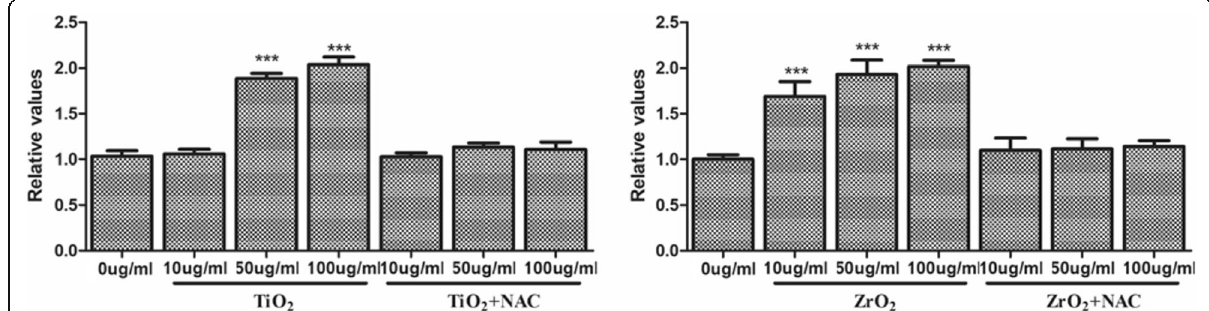
Fig. 3 TiO 2 and ZrO 2 NP-induced ROS generation in 3T3-E1 cells. 3T3-E1 cells were treated with TiO 2 and ZrO 2 NPs at various concentrations for 48 h, and NAC (10 mM) was incubated simultaneously, and then the ROS levels in the 3T3-E1 cells were detected. The results represent the